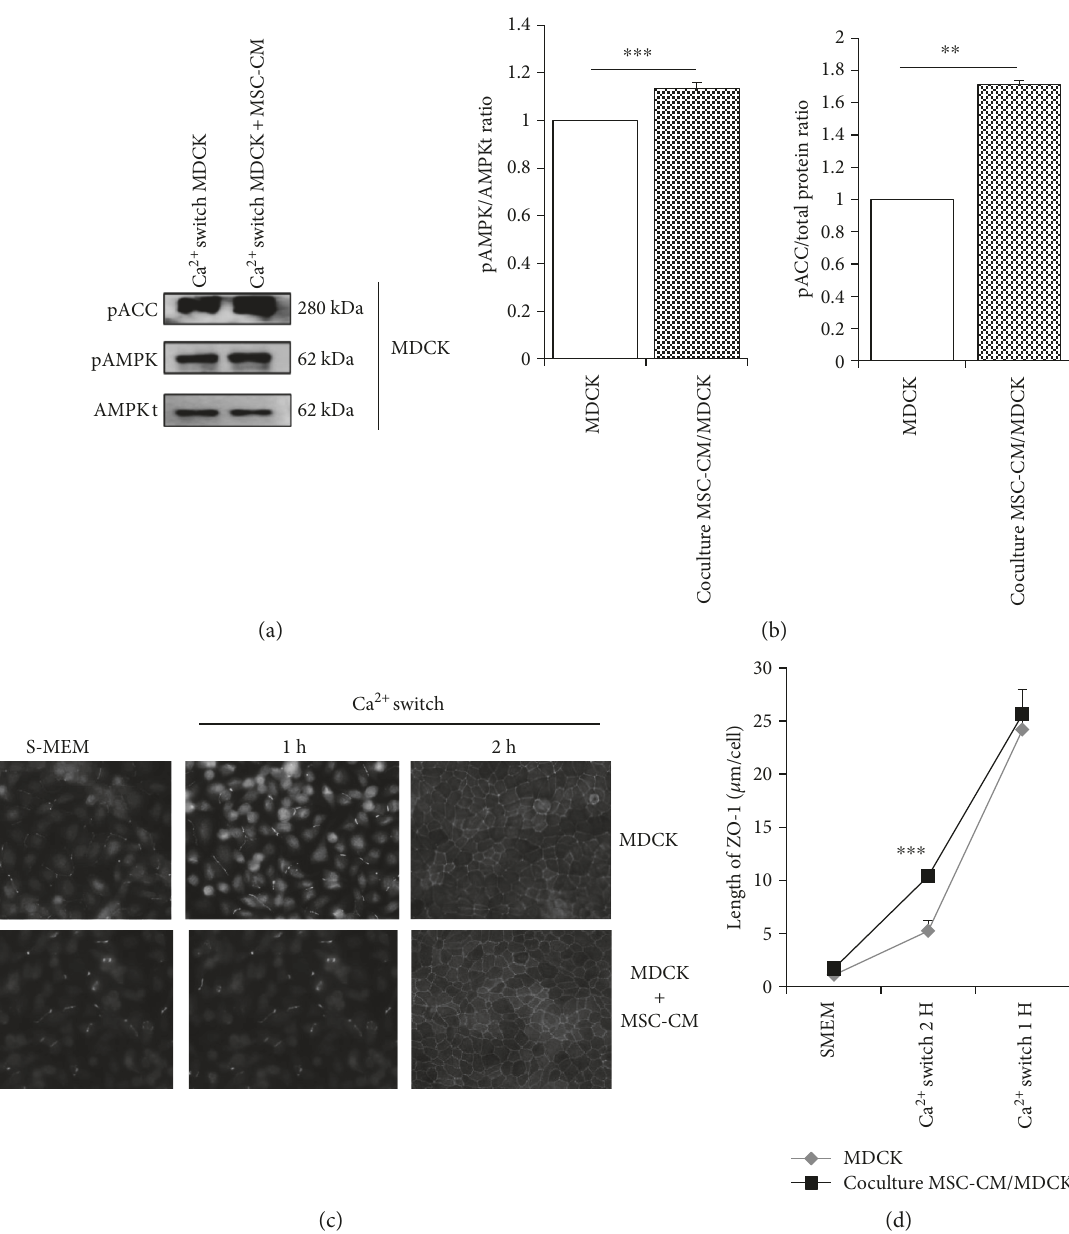
Figure 3: Impact of mesenchymal stromal cell- (MSC-) conditioned medium (CM) on AMPK activation and ZO-1 relocation following a Ca 2+ switch in MDCK cells. Representative immunoblotting (a) and quanti fi cations (b) of phospho-AMP-activated protein kinase (pAMPK) and total AMPK (AMPKt) in low Ca 2+ conditions (S-MEM) and following Ca 2+ switch using MDCK cells exposed to regular versus MSC-preexposed medium. Quanti fi cations of immunoreactive signals were performed by stain-free method after normalization to total protein content of each lane. Representative immuno fl uorescence (c) and quanti fi cations (d) of ZO-1 deposits at increasing time points following Ca 2+ switch in similar conditions as in (a) and (b) (scale bar: 16 μ m). Data are presented as mean ± SD; ∗∗∗ p ≤ 0